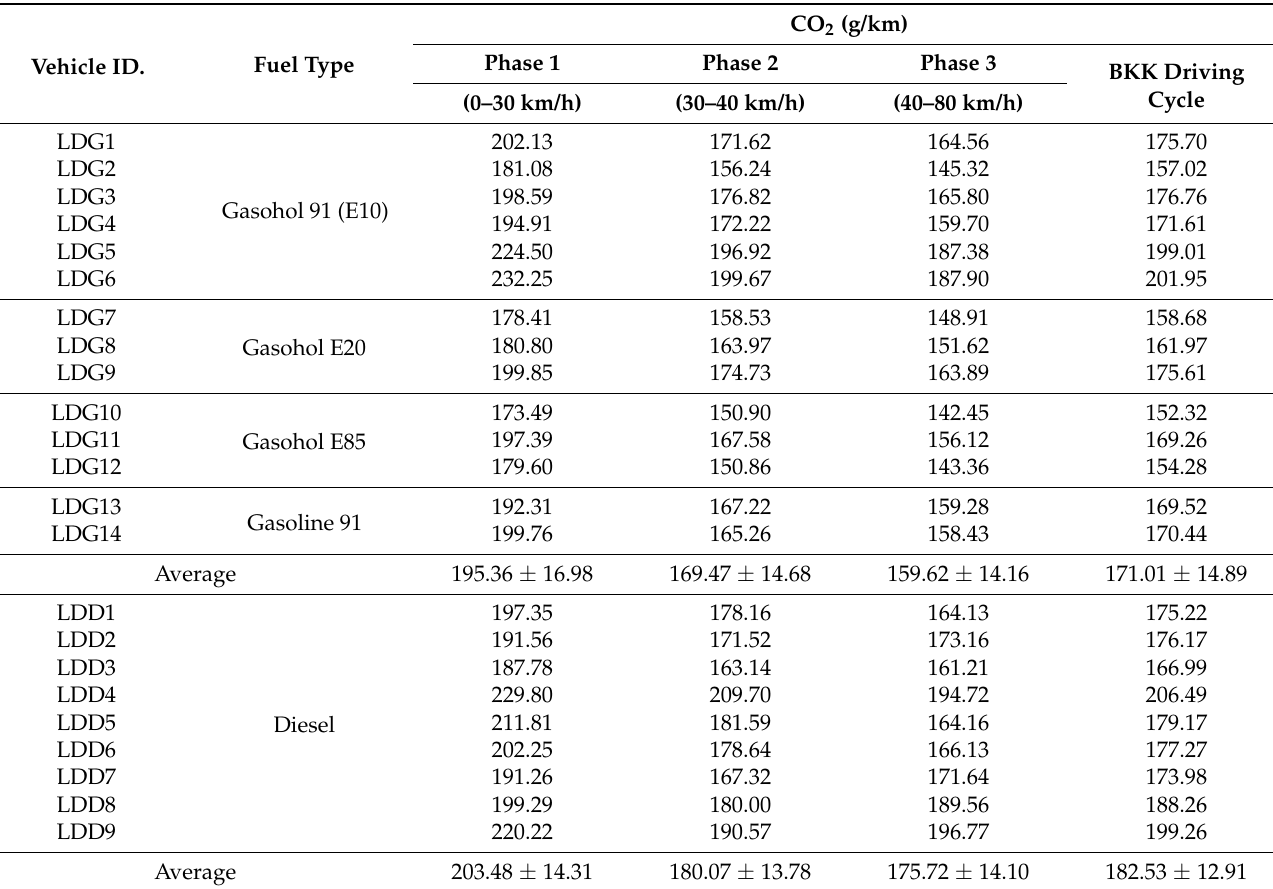
Table 3. CO 2 emission factors from LDG and LDD vehicles varied by fuel types and speed ranges.